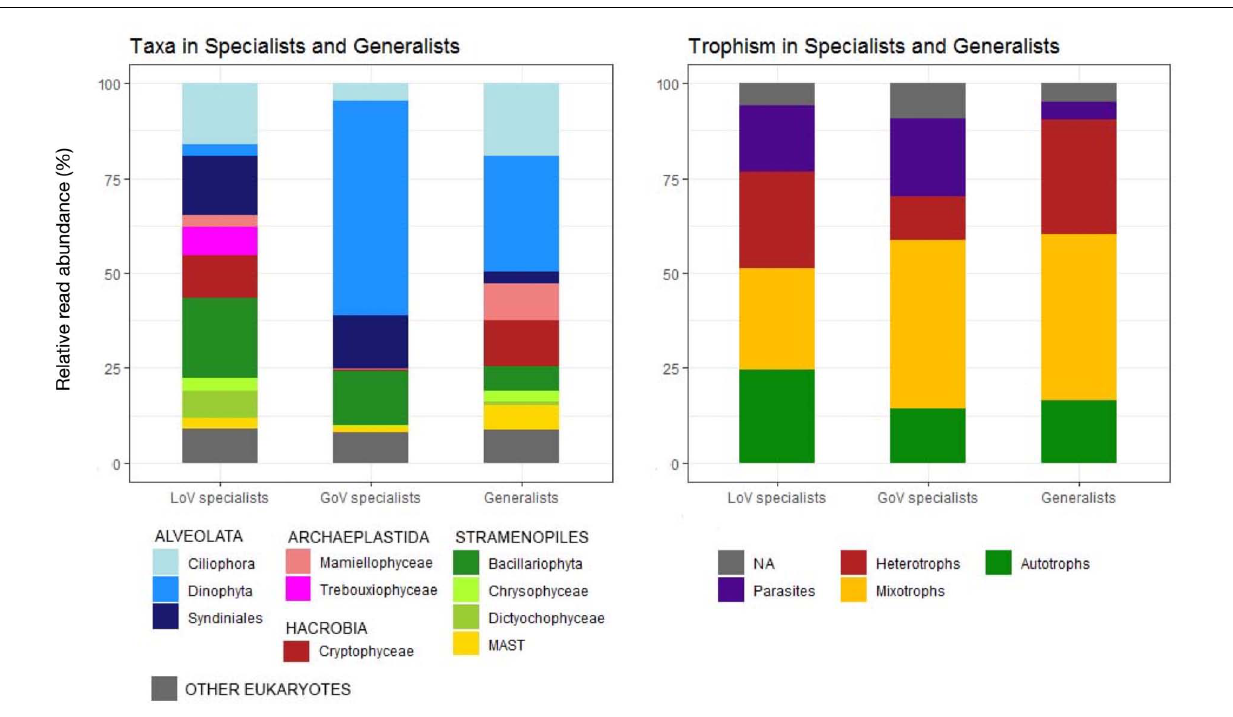
FIGURE 6 | Taxonomic composition and trophic level distribution of generalists and Lagoon (LoV) and Gulf of Venice (GoV) specialists based on the OTU classification obtained with the CLAM tests ( K = 2/3, p < 0.005). Normalized data from two stations in the LoV (St2 and St5) and two in the GoV (PTF and PELL), see Supplementary Material 3